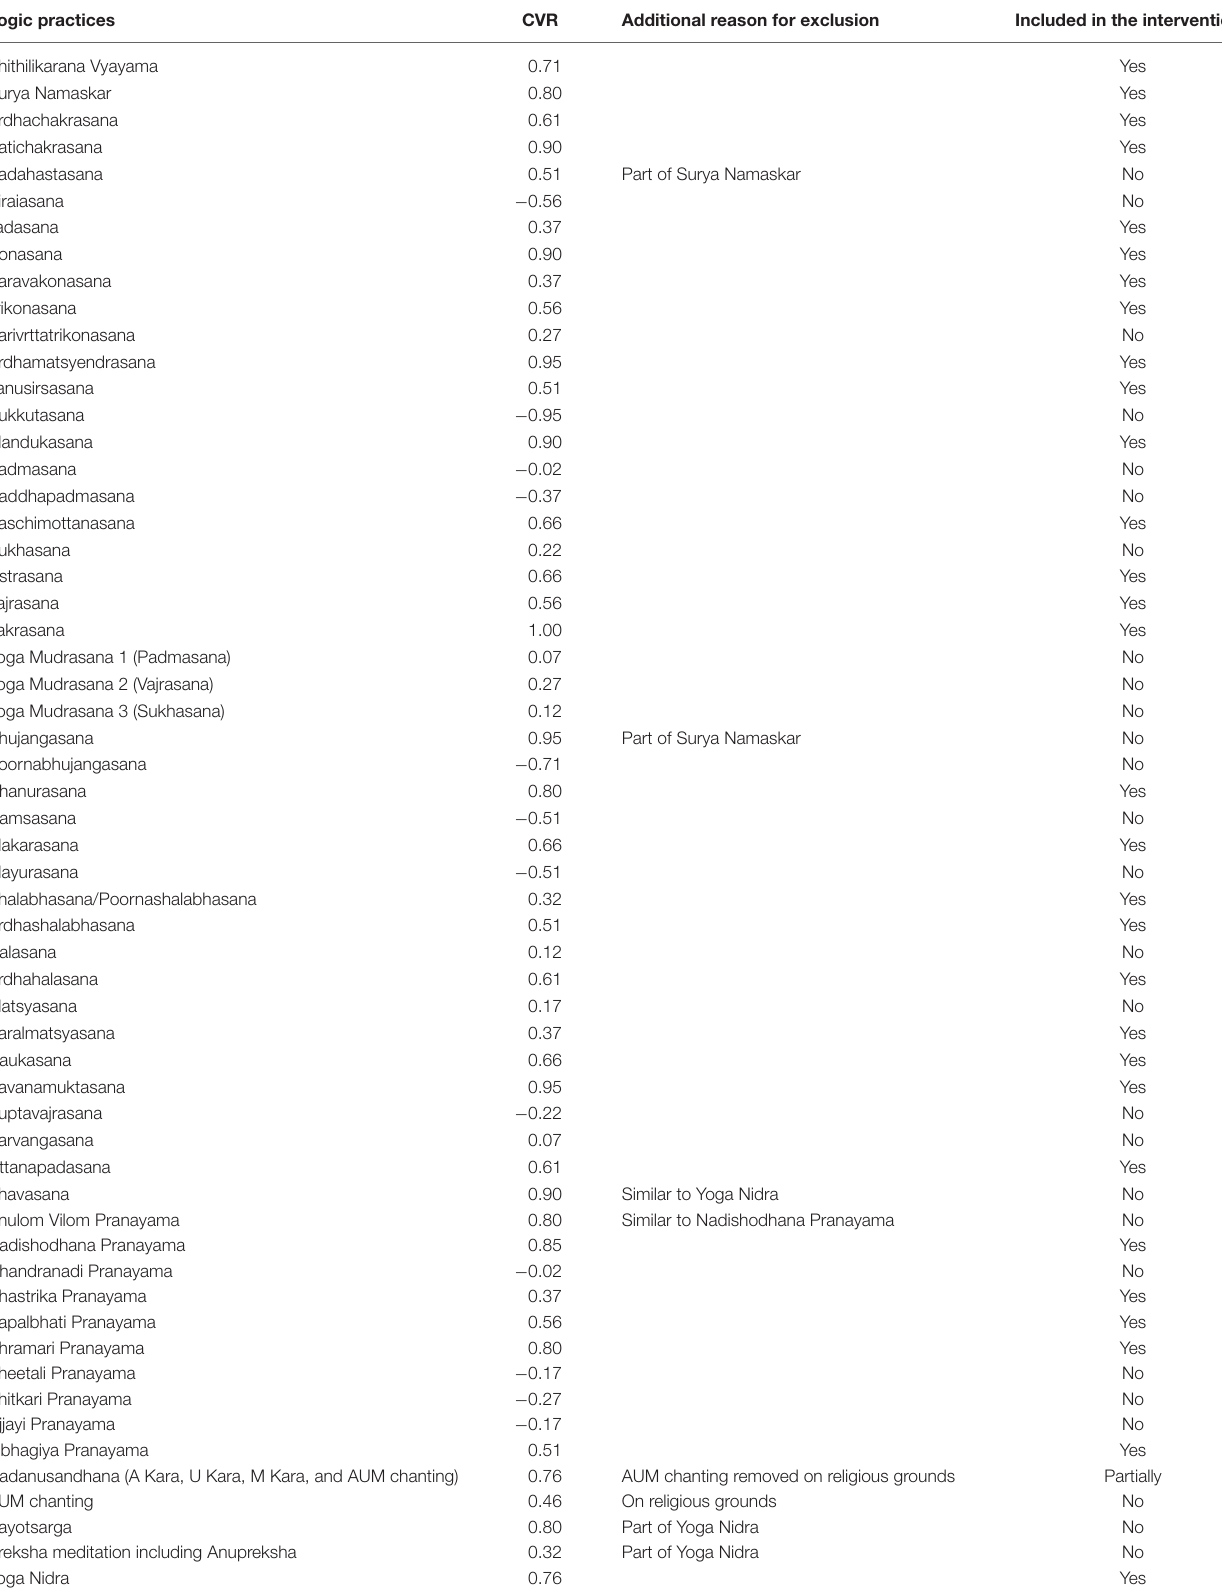
TABLE 2 | Validation of the identified Yogic